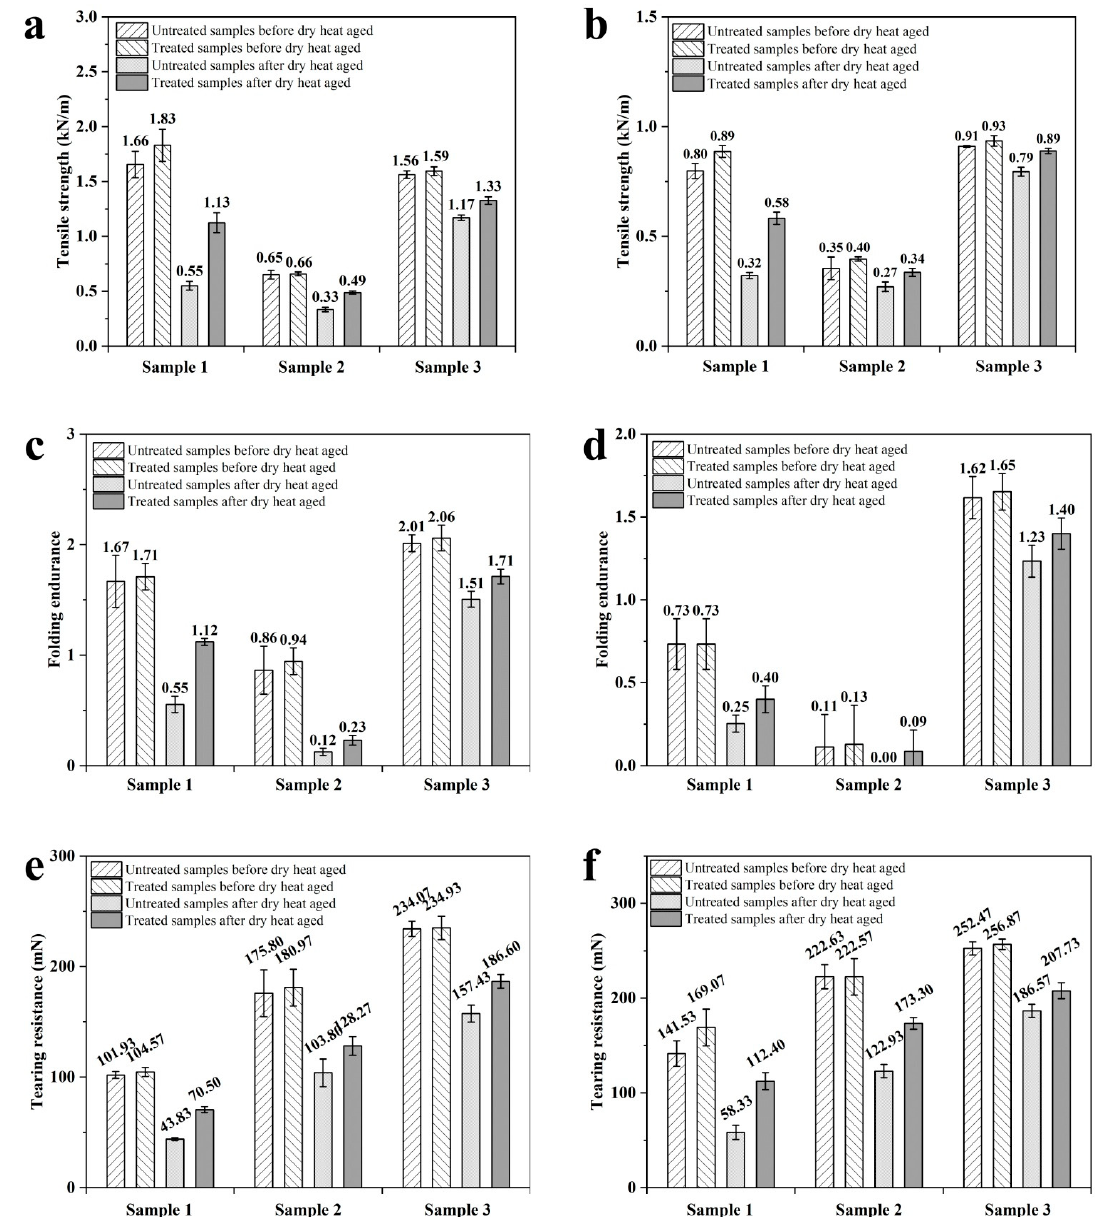
Figure 2. Mechanical strength of treated and untreated paper samples before and after accelerated aging tests: MD of tensile strength ( a ); CD of tensile strength ( b ); MD of folding endurance ( c ); CD of folding endurance ( d ); MD of tearing resistance ( e ); CD of tearing resistance ( f ).